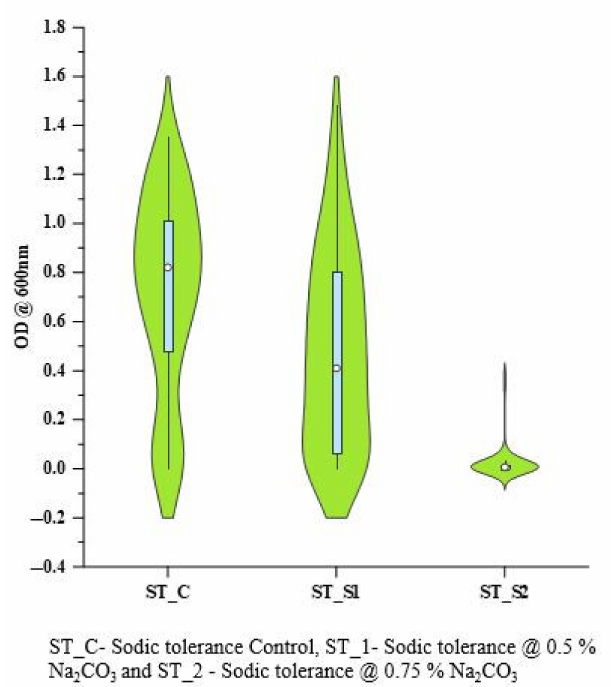
Figure 3. Bacterial growth in stressed and unstressed conditions. ST_C—Sodic tolerance for control, ST_S1—sodic tolerance at 0.5% Na 2 CO 3 and ST_S2—sodic tolerance at 0.75% Na 2 CO 3 . PCA was performed to choose the better EPS-producing STB isolates (Figure 4). The biplot showed that EPS production and bacterial growth under stress conditions were more influenced by parameters. The bacterial isolates were orthogonally spread over the four quadrants. The cultures laid in the ( − , − ) quadrant were considered to have less sodic tolerance with EPS production. Thus, the cultures spread across the (+, +), (+, − ) and ( − , +) quadrants (a total of 28 cultures) were chosen to examine their PGP activities (Figure 4).